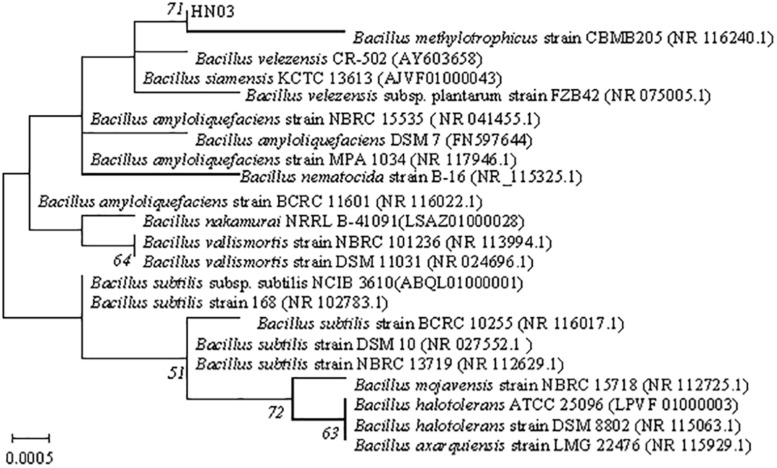
Maximum-likelihood phylogenetic tree based on partial 16S rRNA gene sequences (1,424 bp) showing the position of strain HN03. Bootstrap values (>50%) based on 1,000 replications are shown at branch nodes. Bar = 0.0005 substitutions per nucleotide position.